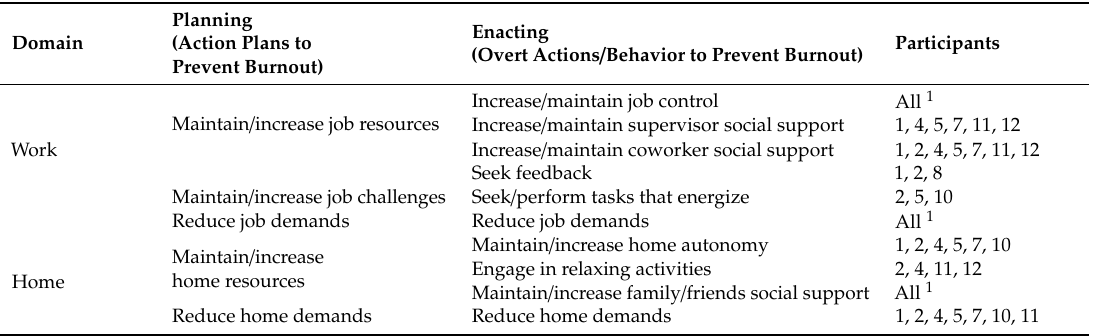
Table 1. Proactive burnout prevention planning and enacting stages and the participants identifying each proactive